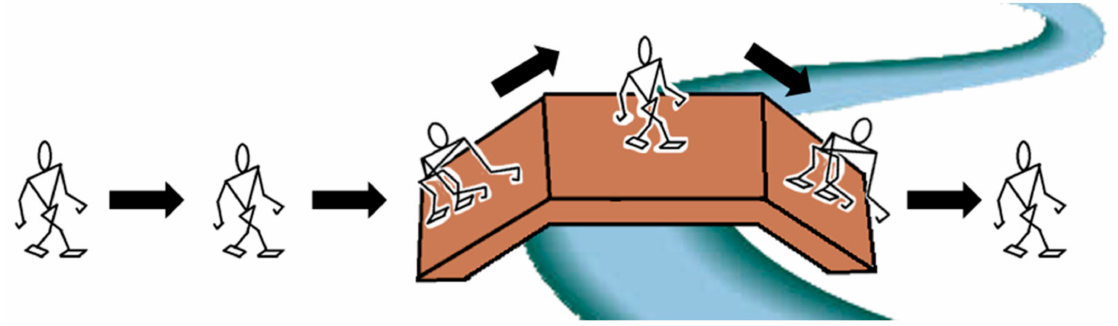
Figure 2. MLR goes over a bridge above a